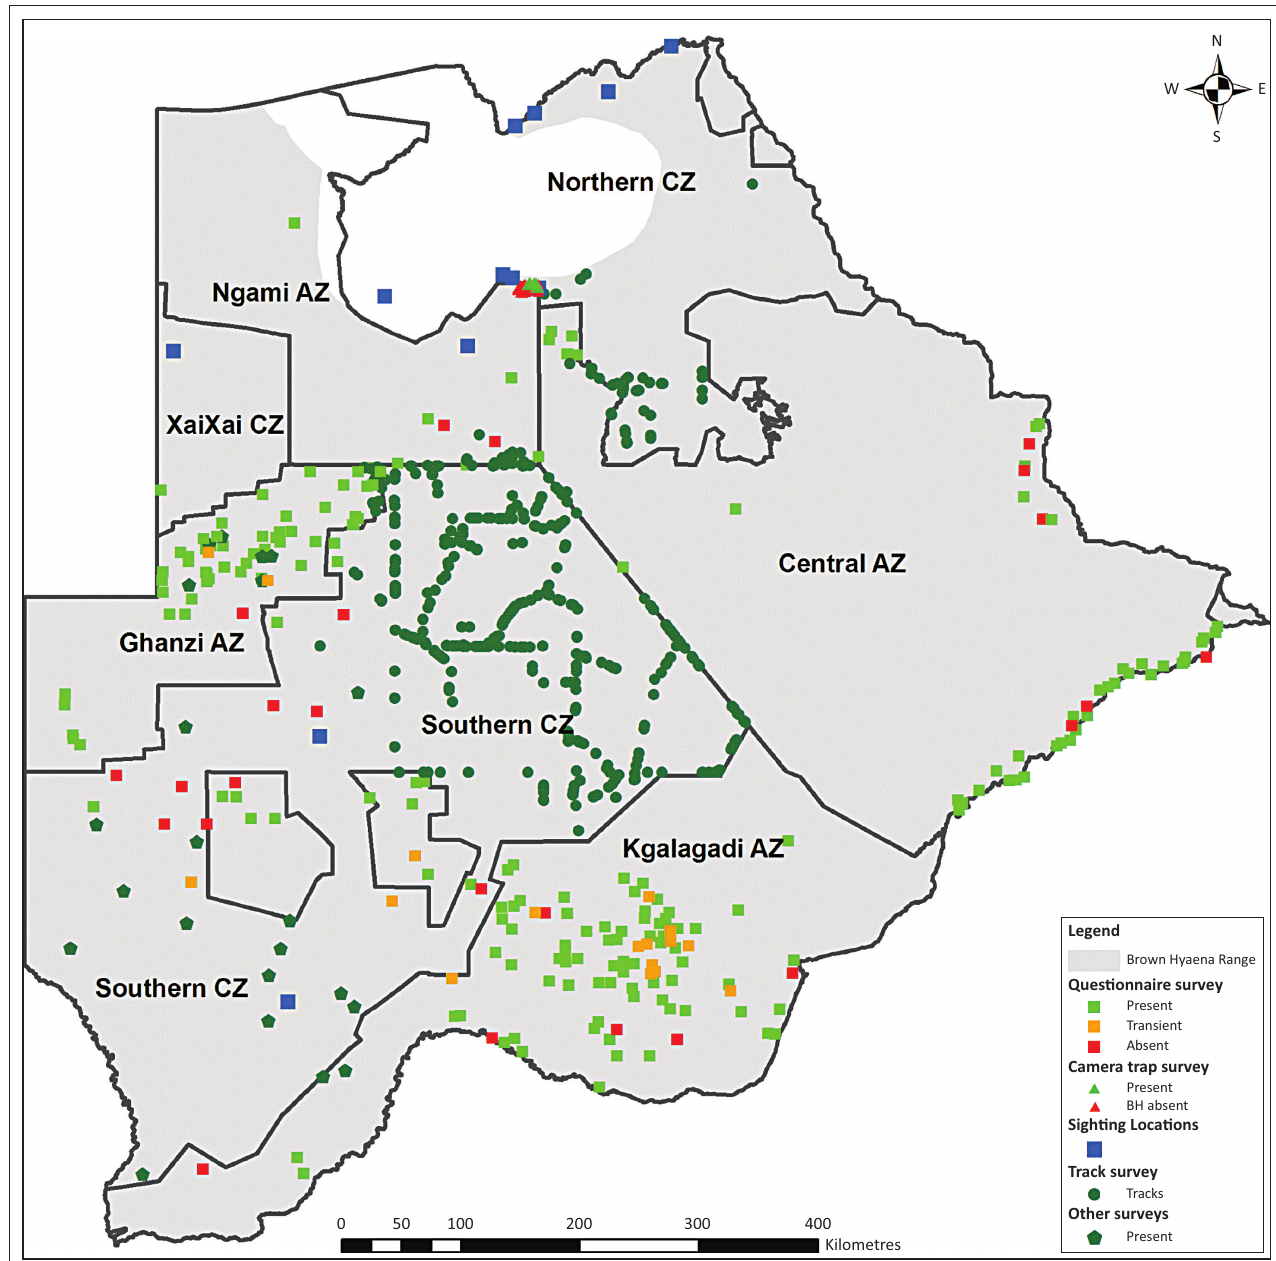
FIGURE 3: Brown hyaena ( Parahyaena brunnea ) distribution range in Botswana based on occurrences recorded between 2005 and